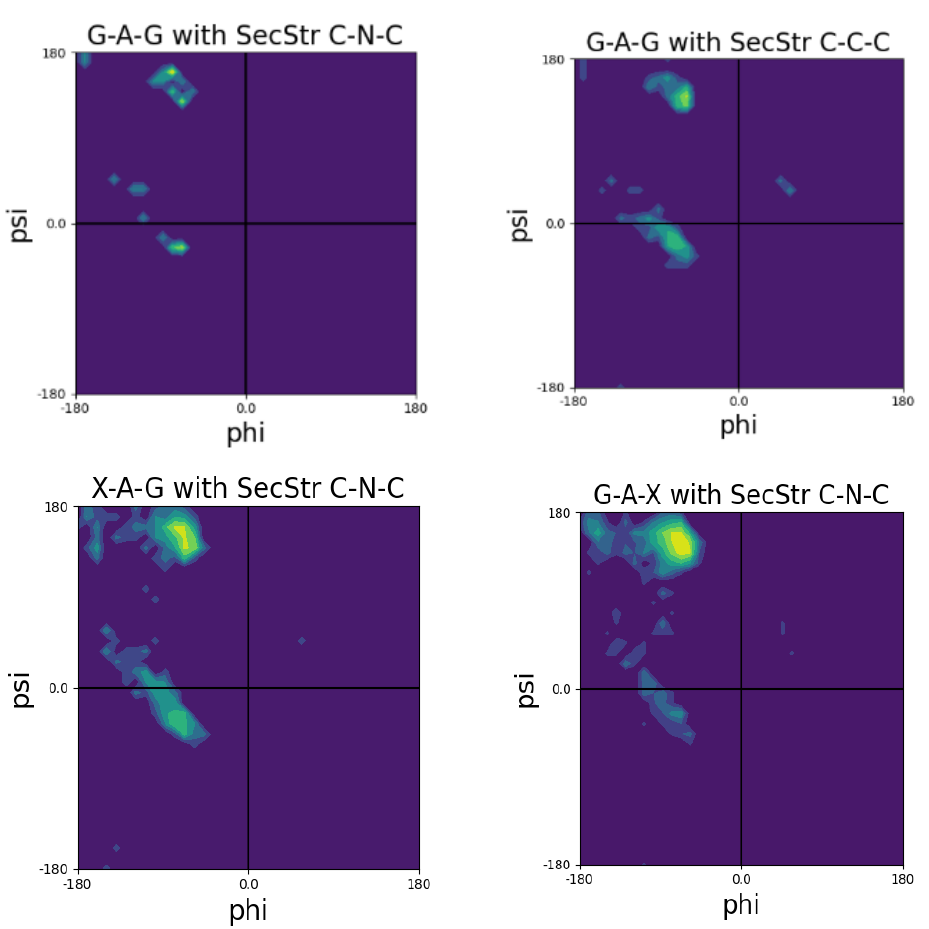
Figure 5. Ramachandran plots of the central residue in the indicated tripeptide sequences. Upper panel: ( Left ) only alanine residues in coils were considered; ( Right ) only alanine residues outside of helices and β -sheets were considered. Lower panel: X indicates the summation over all nearest neighbors outside of helices and β -sheets. The plots were directly taken from the website of the Sosnick group [70].